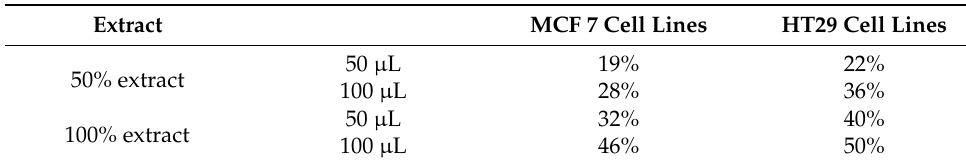
Figure 4. Effect of plant extract on MCF7 cancer cell lines. ( a ) The control samples (DMSO); ( b ) 50 μL of 50% extract; ( c ) 100 μL of 50% extract; ( d ) 50 μL of 100% extract; ( e ) 100 μL of 100% extract. The figures are at magnification 400×. Table 4. Percentage of dead cells results by extracts.